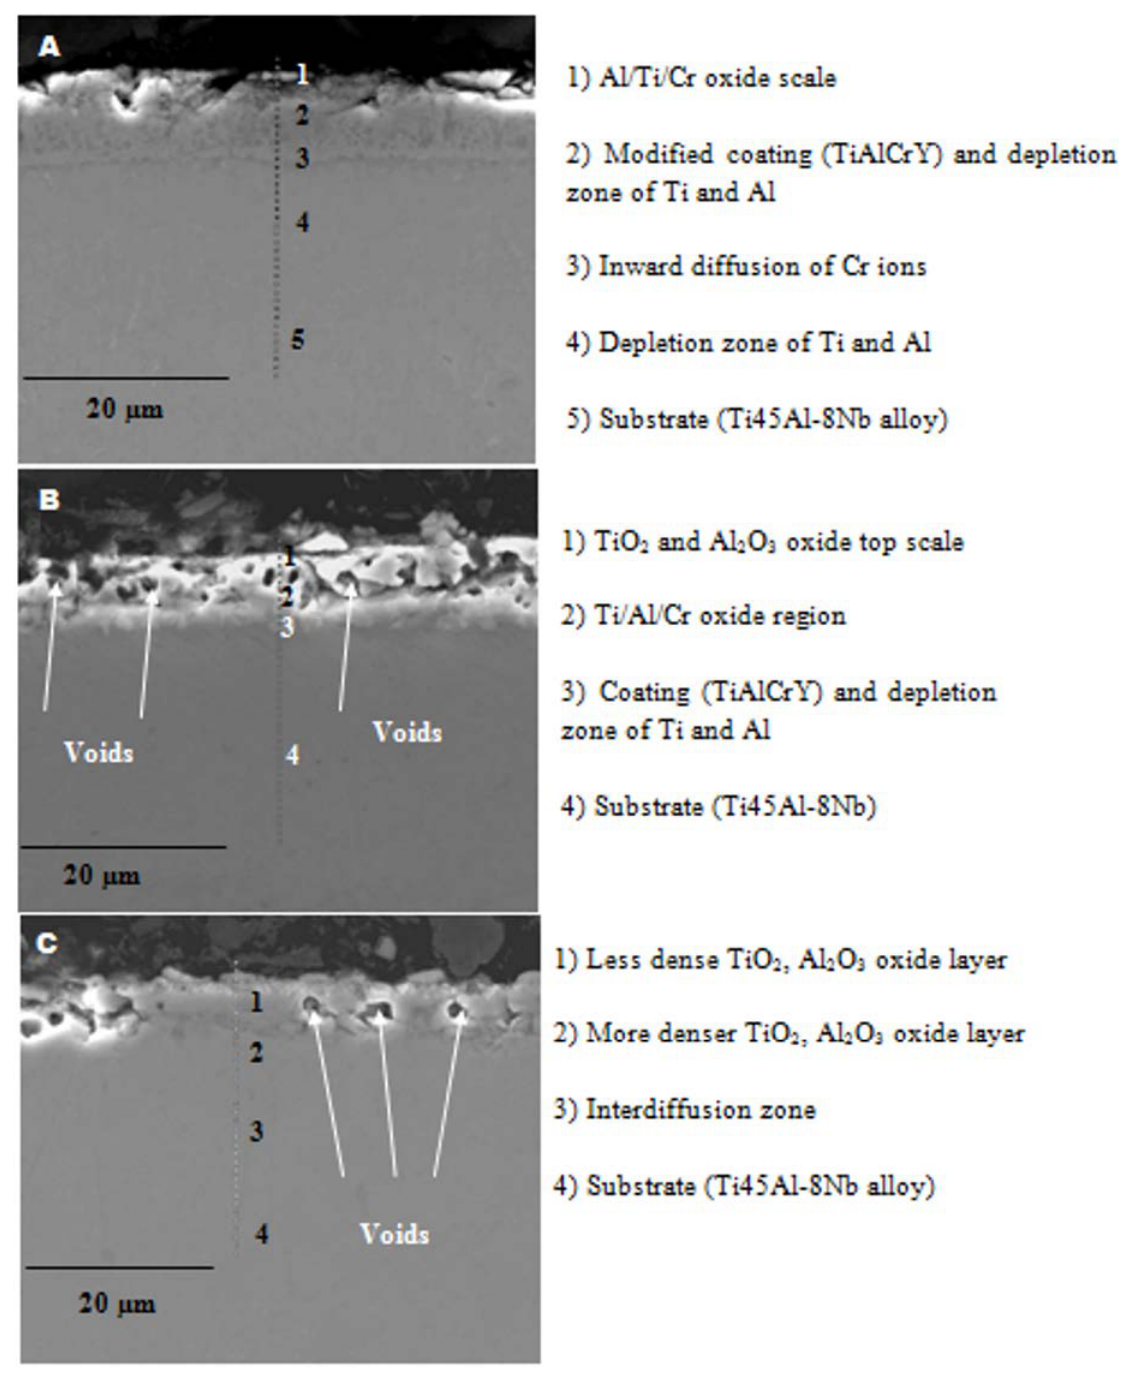
Figure 3. Cross - section SEM image in SE mode of TiAlCrY coated Ti45Al8Nb alloy after 500 hours of oxidation at A) 750 ◦ C, B) 850 ◦ C and C) 950 ◦ C